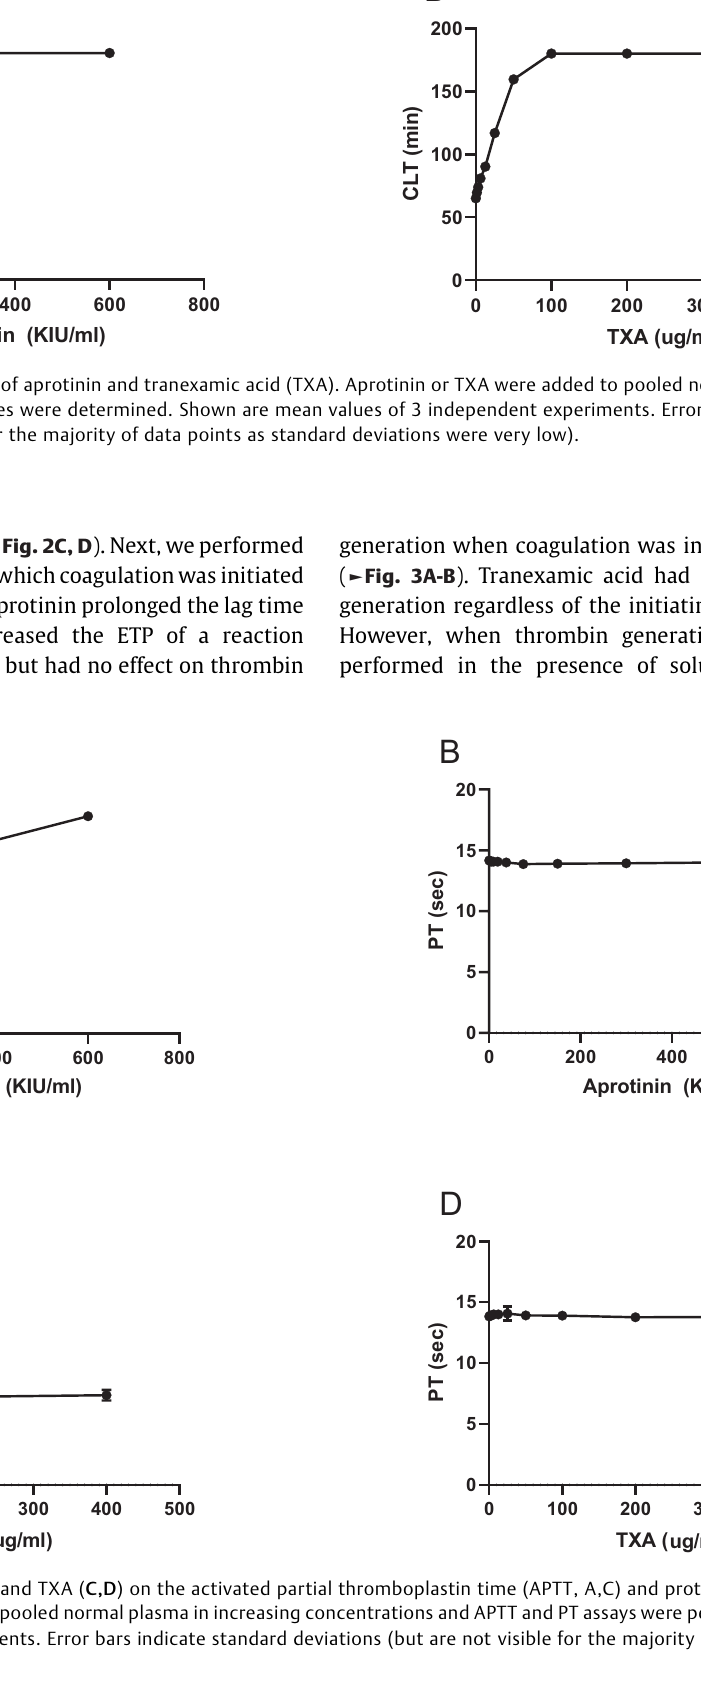
TH Open Vol. 5 No. 3/2021 © 2021. The